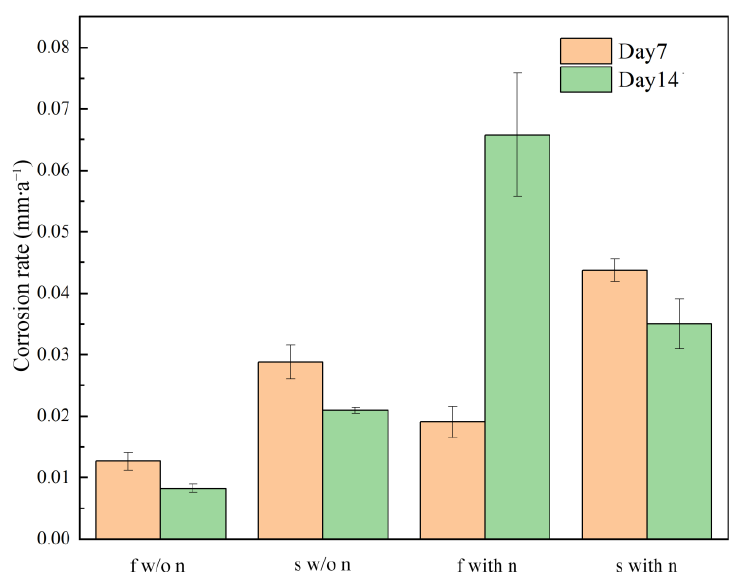
Figure 4. Corrosion rate of EH40 steel after 7 and 14 days of immersion in different systems (f w/o n: full system without nitrate addition, s w/o n: starvation system without nitrate addition, f with n: full system with nitrate addition, and s with n: starvation system with nitrate addition).